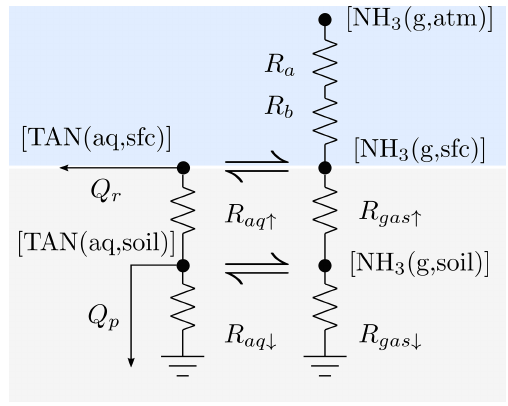
Figure 1. A resistance scheme representing transport processes be- tween the atmosphere, soil immediately below the surface, and the deeper soil. The aerodynamic and quasi-laminar layer resistances are denoted by R a and R b . Resistances controlling the diffusive transport upwards ( ↑ ) and downwards ( ↓ ) are denoted by R aq and R gas for aqueous and gaseous phases; runoff and leaching fluxes are denoted by Q r and Q p . Phase equilibria are denoted with (cid:10)